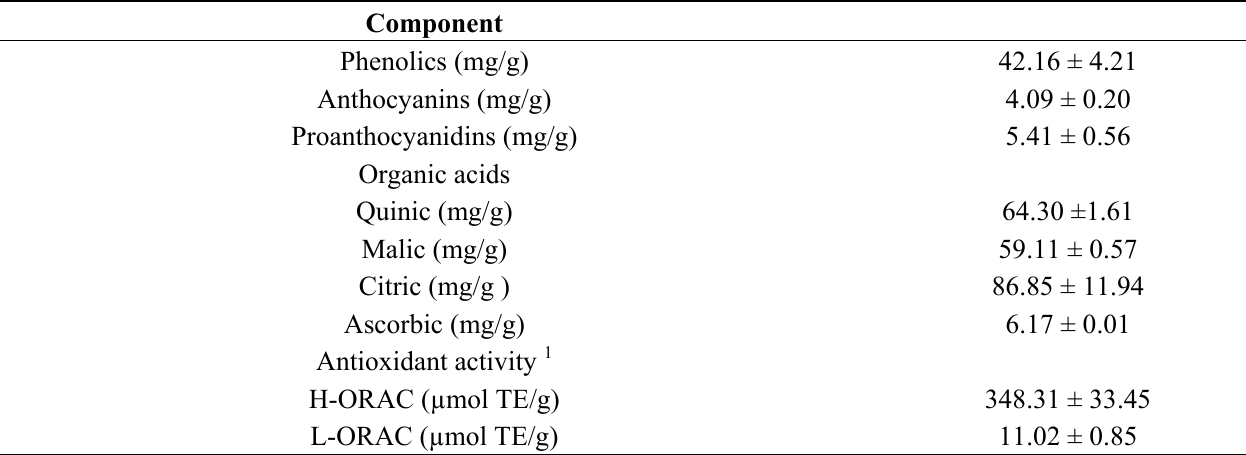
Table 1. Total phenolics, organic acids, and antioxidant activity of freeze-dried whole cranberry extract